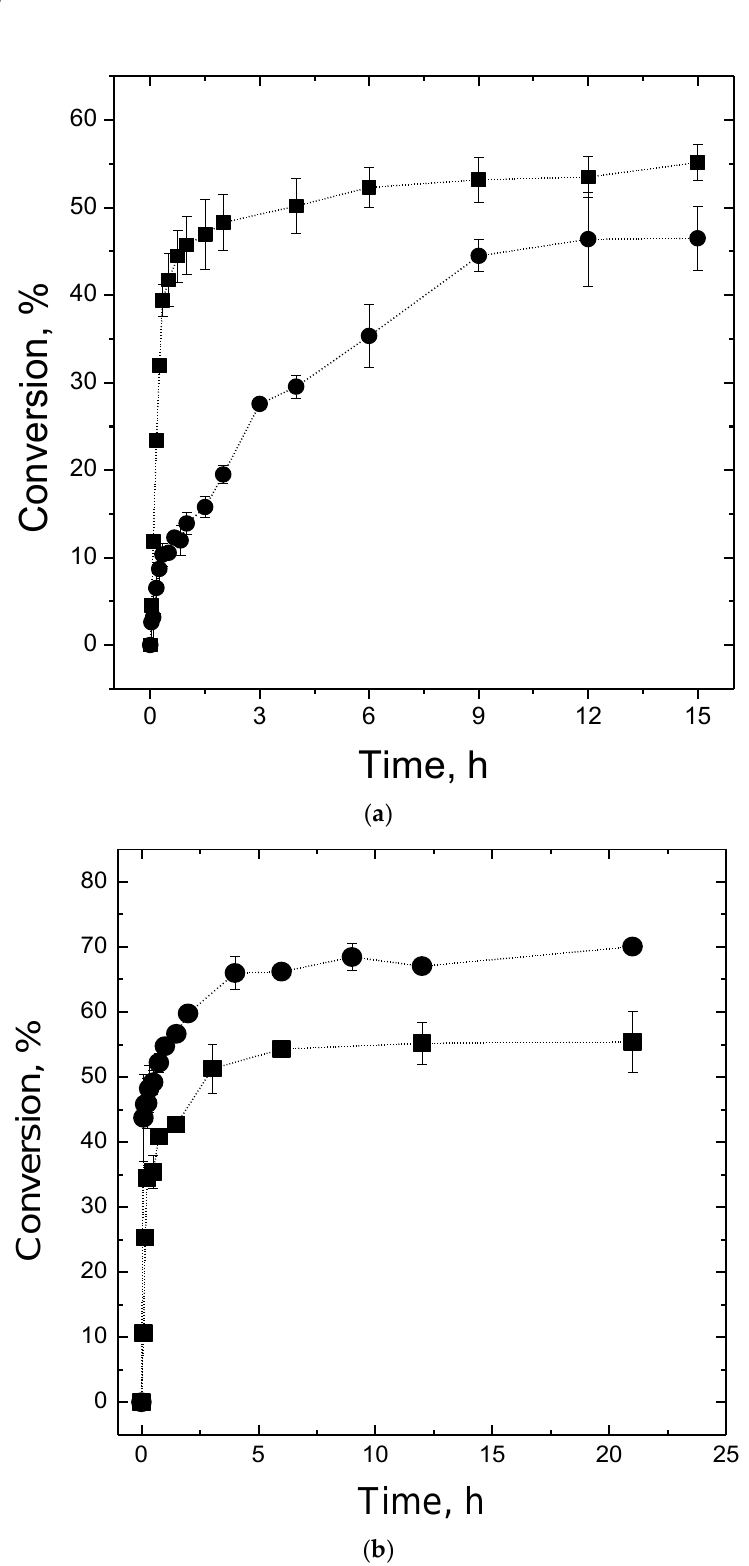
Figure 4. Comparative soluble starch (30 g/L) conversion using free β-amylase (squares) and CLEA-β-PS-12 (circles) at pH 7.0 and 40 °C; ( a ) comparative starch conversion using cassava bagasse starch solutions with free β-amylase (squares) and CLEA-β-PS-12 (circles), using 1.2 U/g of starch, pH 7.0 and 40 °C ( b ).